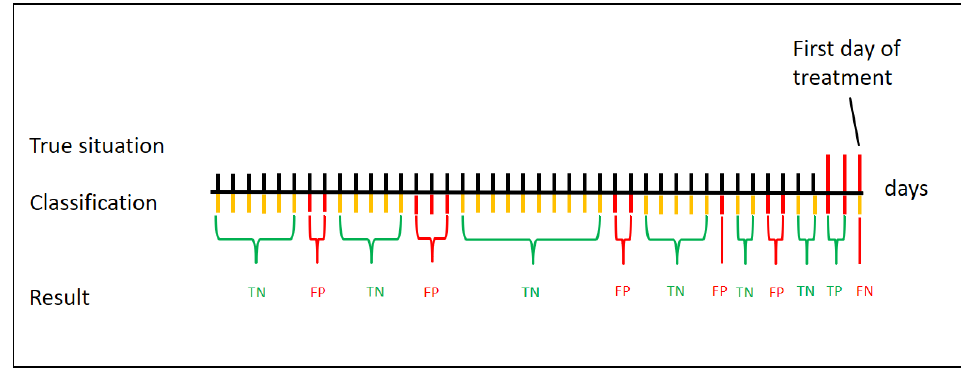
Figure 4. Example classification of days for a single cow with a treatment (last 3 days labeled positive). Yellow bars mean no alert, red bars mean alerts. Green brackets indicate true negative and true positives days, red brackets indicate false-positive and false-negative days.